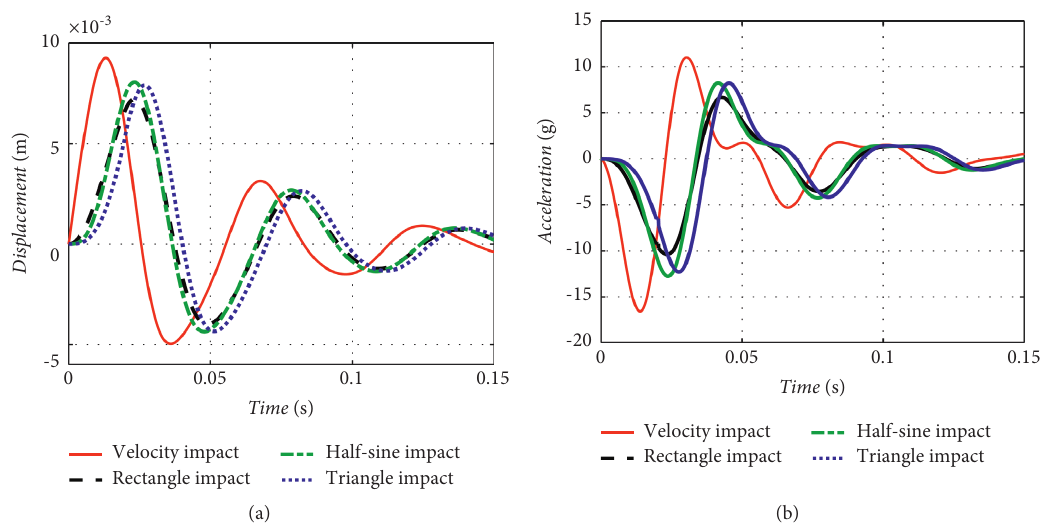
Figure 9: Response of a packaging system with cubic stiffness under different excitations at a duration of 20ms. (a) Displacement. (b)